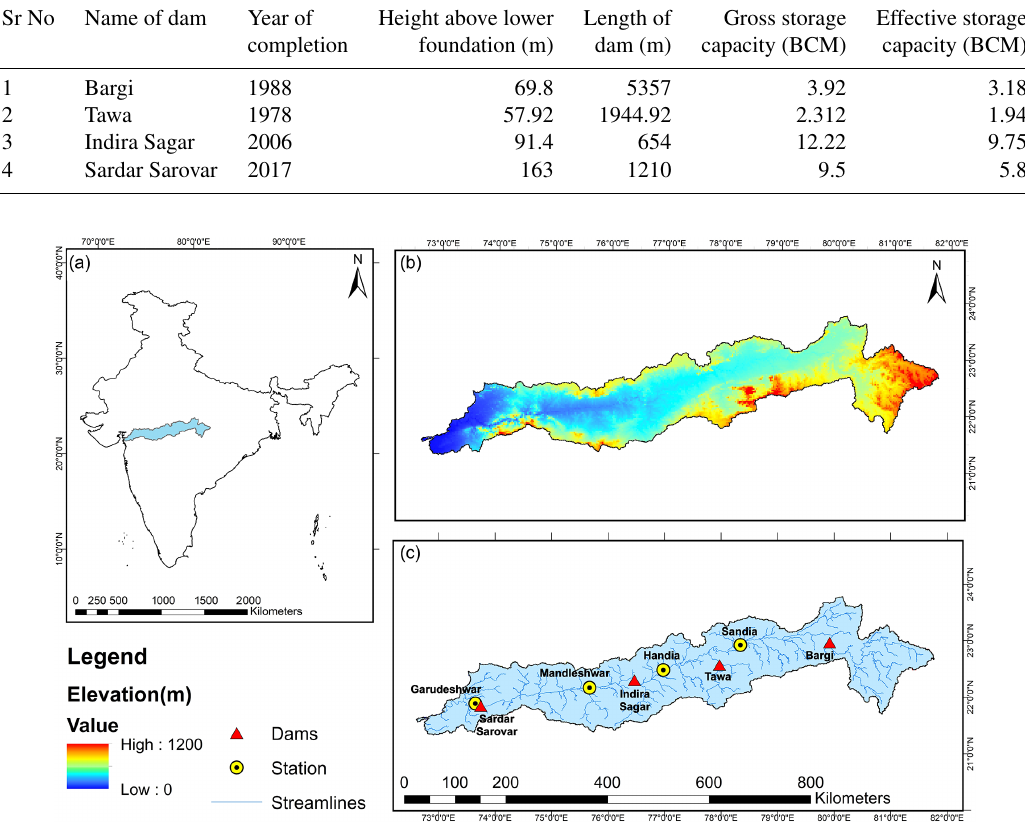
model. The model uses vegetation cover for each tile